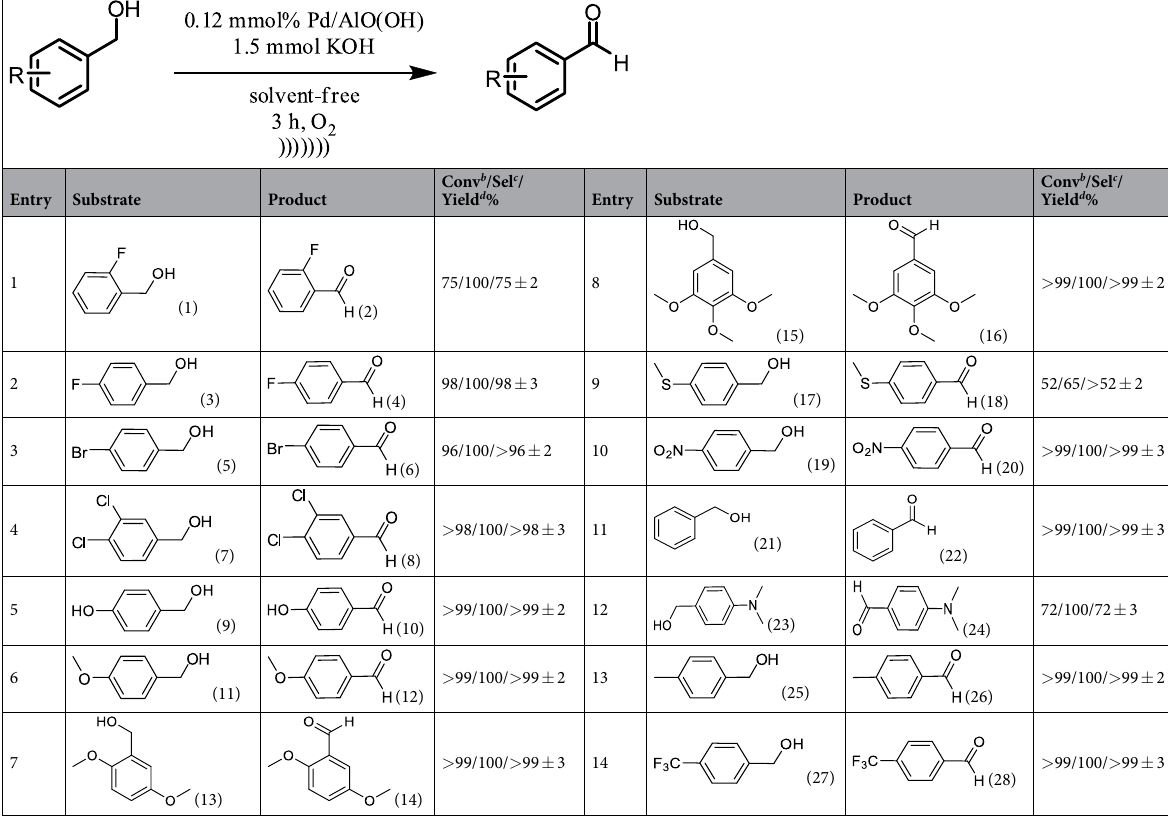
Table 2. Aluminum oxy-hydroxide-supported palladium nanoparticles catalyzed the oxidation of various benzyl alcohol compounds. a Unless otherwise stated, 1.0 mmol of the substrate, 1.5 mmol of KOH, and NMR results. d Determined by 1 H NMR analysis.